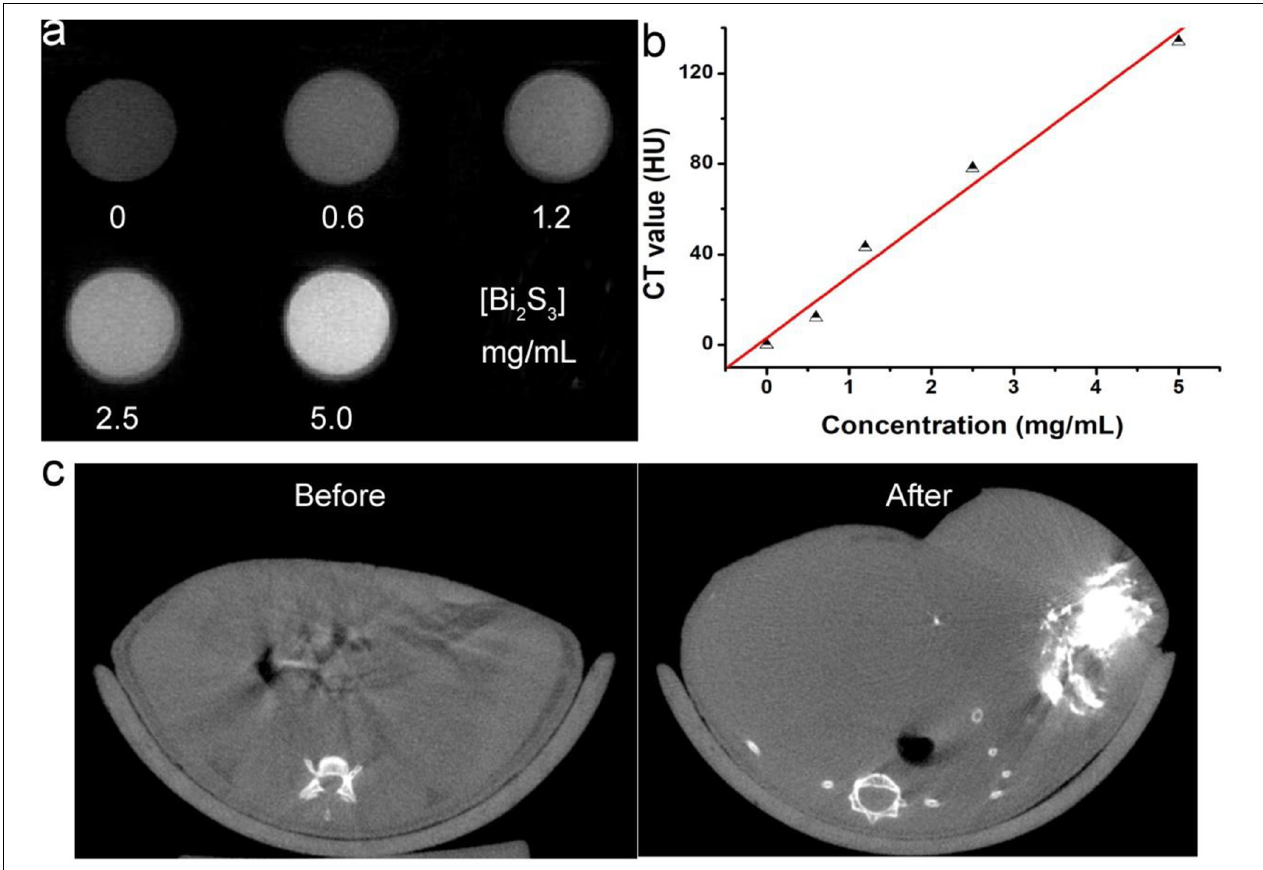
FIGURE 5 | (a) CT signals of Bi 2 S 3 nanorods. (b) CT value as a function of the concentration of Bi 2 S 3 nanorods. (c) CT image of a mouse before (left) and after (right) the injection of Bi 2 S 3